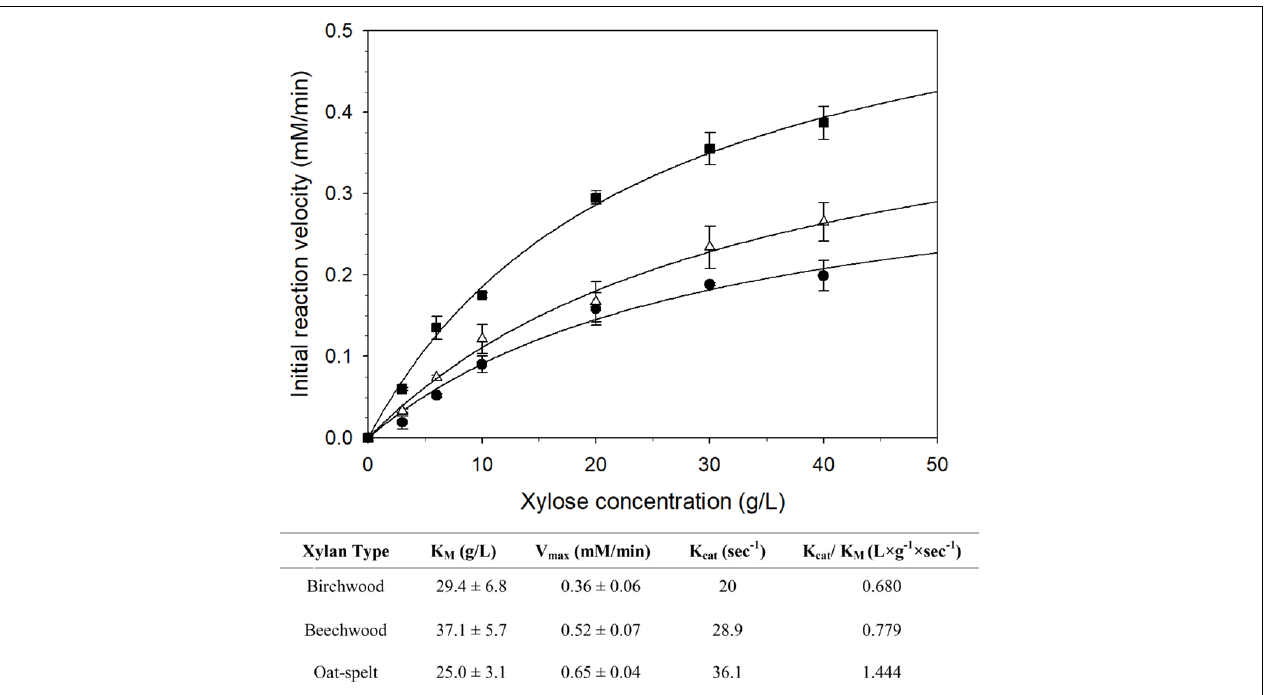
FIGURE 5 | Michaelis-Menten plots for the determination of the K M values of XynDZ5 for three xylan types. The initial reaction velocities (determined from the reducing sugars produced and expressed as equivalent xylose) were obtained in the standard assay mixture at pH 7 and 65 ◦ C with an enzyme concentration of 0.3 µ M, birchwood xylan ( • ), beechwood xylan ( (cid:77) ), oat-spelt xylan ( (cid:4) ). Data were fitted using the non-linear regression routines of SigmaPlot software. Values represent the mean of triplicate experiments and the error bars correspond to one standard deviation from the mean value. The table summarizes the kinetic constants determined from the above regression